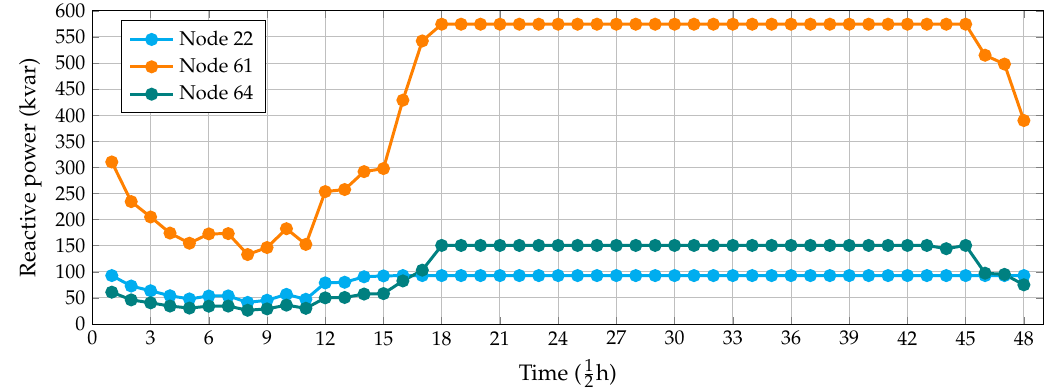
Figure 4. Daily reactive power injection in the selected nodes where the STATCOMs were installed in the IEEE 69-bus